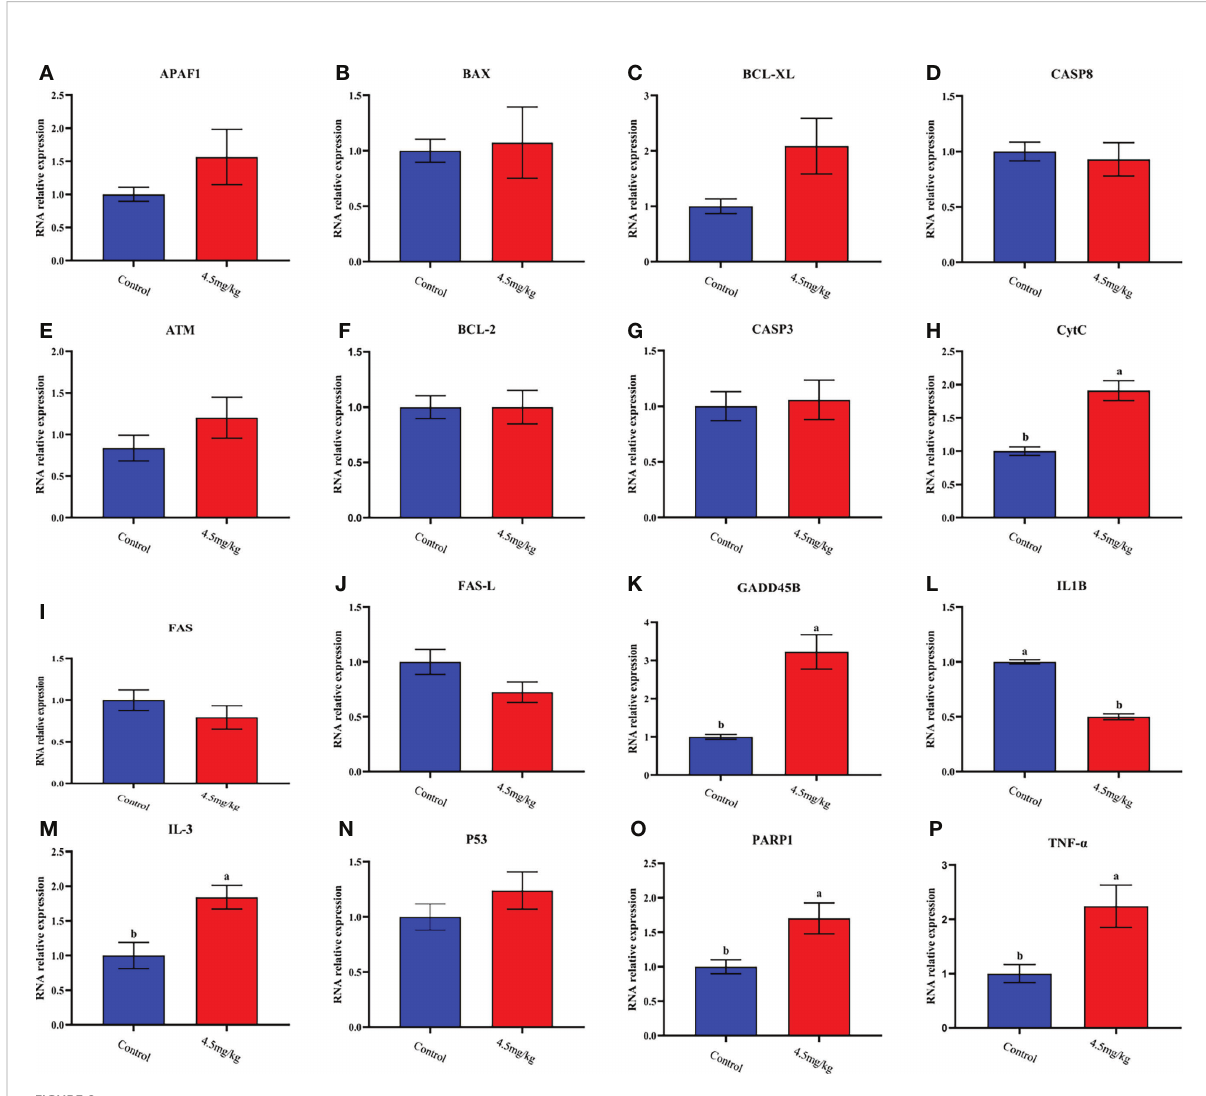
FIGURE 9 Quantitative analysis of apoptosis and collateral genes in back muscle tissue (A) APAF1; (B) BAX; (C) BCL-XL; (D) CASP8; (E) ATM; (F) BCL-2; (G) CASP3; (H) CytC; (I) FAS; (J) FAS-L; (K) GADD45B; (L) IL-1 b ; (M) IL-3; (N) P53; (O) PARP1; (P) TNF- ɑ ; Different lowercase letters indicate P <0.05 vs